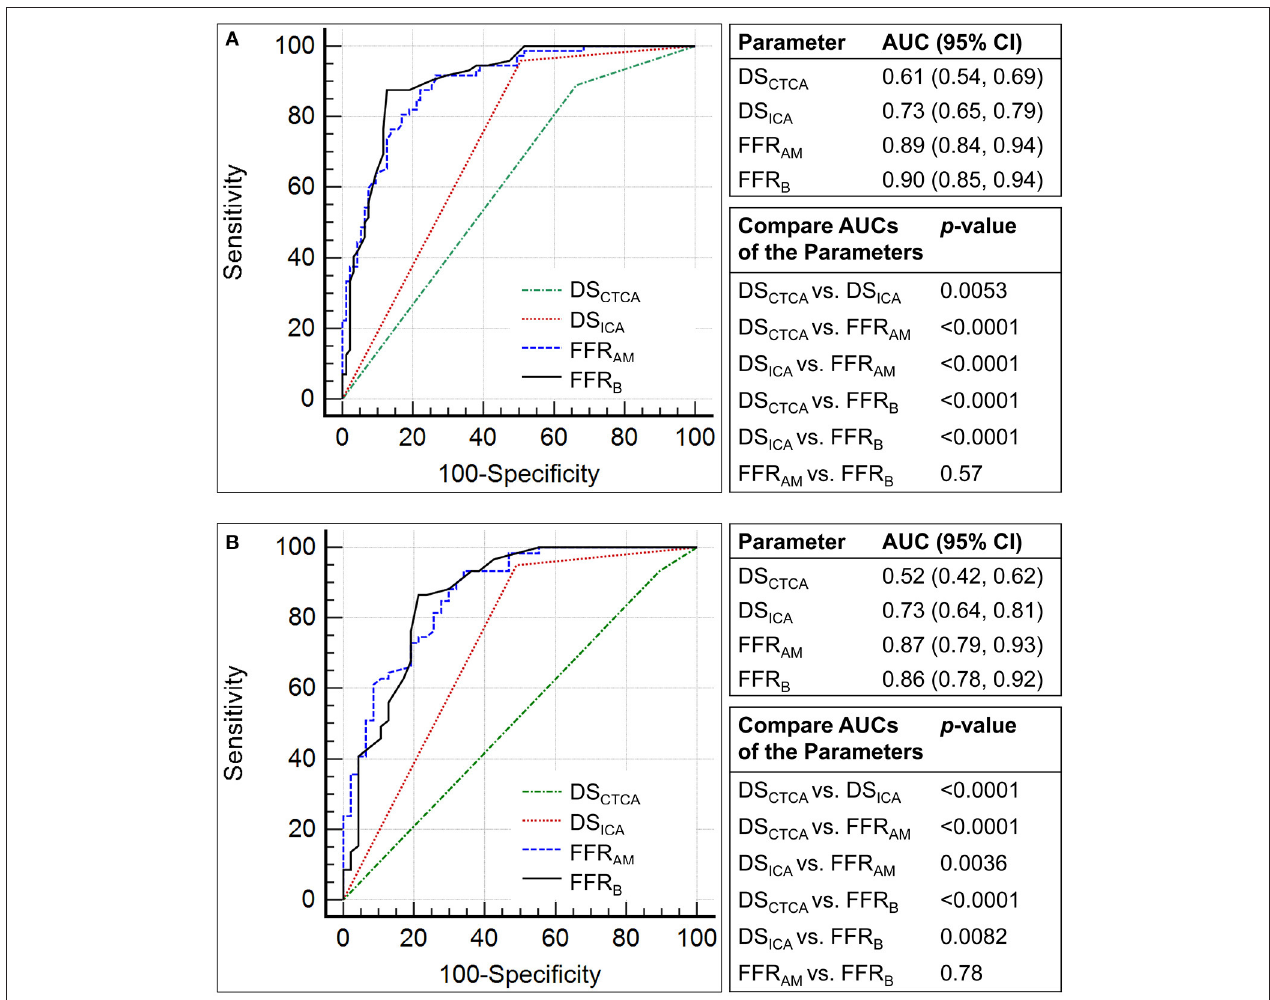
FIGURE 5 | Comparison of the receiver operating characteristic curves for the discrimination of myocardial ischemia (fractional flow reserve, FFR ≤ 0.8) using diameter stenosis (DS; DS CTCA and DS ICA , with a threshold of 50%) and non-invasive FFR (FFR AM and FFR B ) on (A) per-vessel and (B) per-patient levels.